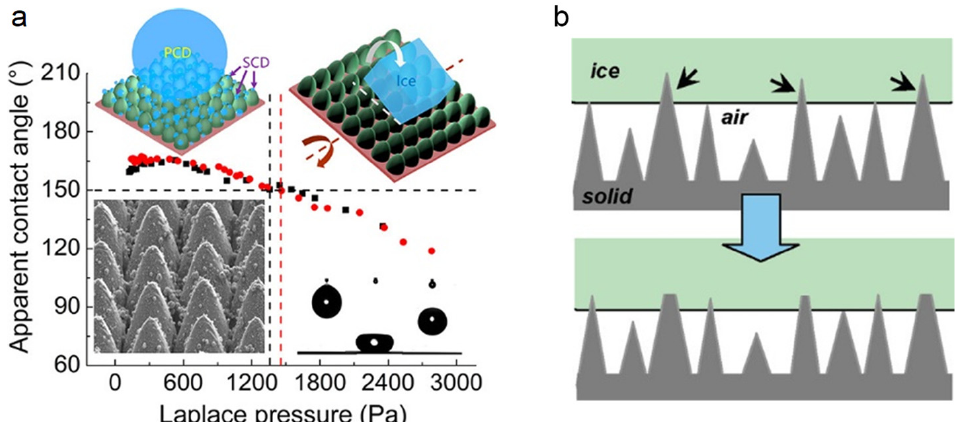
Figure 3. Superhydrophobic surfaces for anti-icing. ( a ) Three-scale micro-/nanostructured superhydrophobic surface [35]. ( b ) Microstructure of superhydrophobic surface is destroyed during removal of ice, resulting in a decrease of icephobicity [39]. Figures reproduced corresponding to publishers ACS.